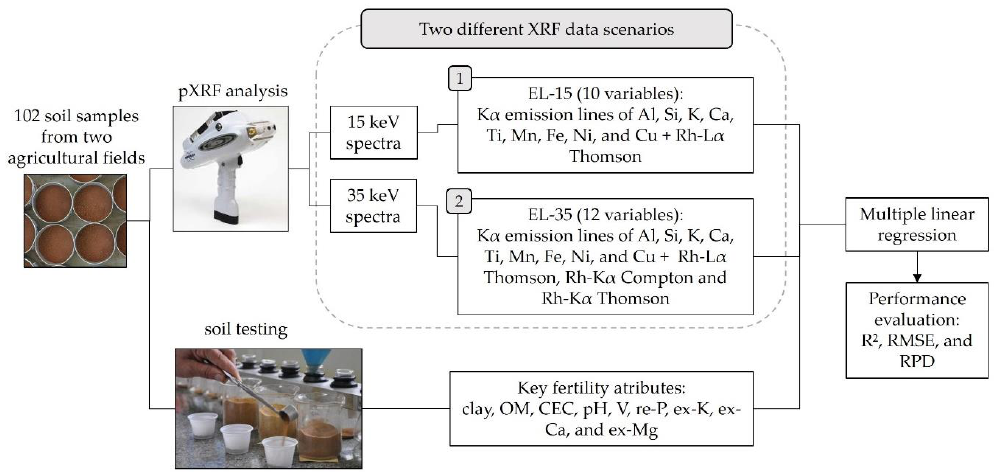
Figure 3. Framework of the methodology applied for the development of calibration models for clay, organic matter (OM), cation exchange capacity (CEC), pH, base saturation (V), resin-extracted (re-) P, and exchangeable (ex-) K, Ca, and Mg using an X-ray fluorescence (XRF) sensor configured with two different X-ray tube voltages (15 and 35 kV). For the X-ray tube set at 15 kV, 10 XRF lines were selected, comprising the Kα emission line of aluminium (Al), silicon (Si), potassium (K), calcium (Ca), titanium (Ti), manganese (Mn), iron (Fe), nickel (Ni), copper (Cu), and the scattering peak Rh- Lα Thomson;